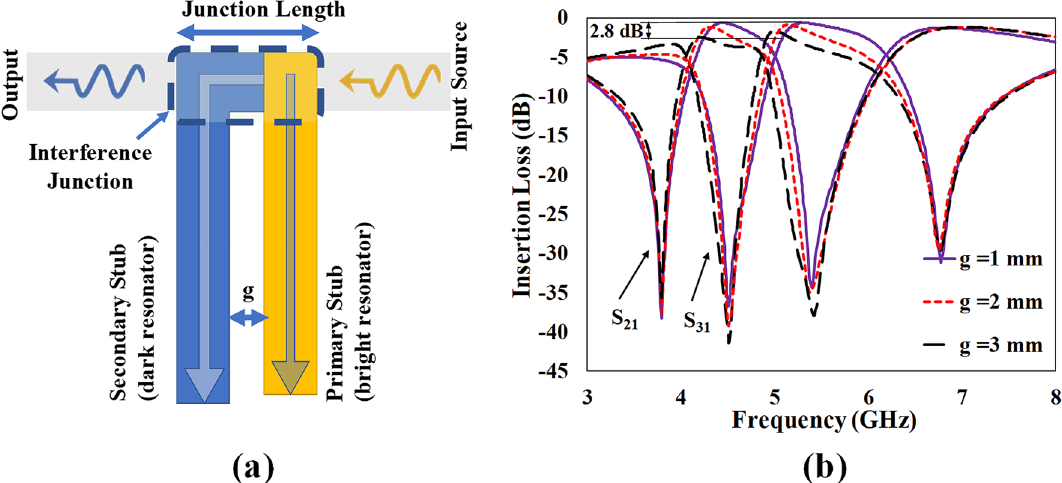
Figure 7. Effect of changing the junction length between the stubs ( a ) a representative example to show the junction length with dual stubs ( b ) The EIT-like response of full diplexer, the increase in the insertion loss of 2.8 dB is observed due to increase in the inter-resonator distance from 1 to 3 mm.